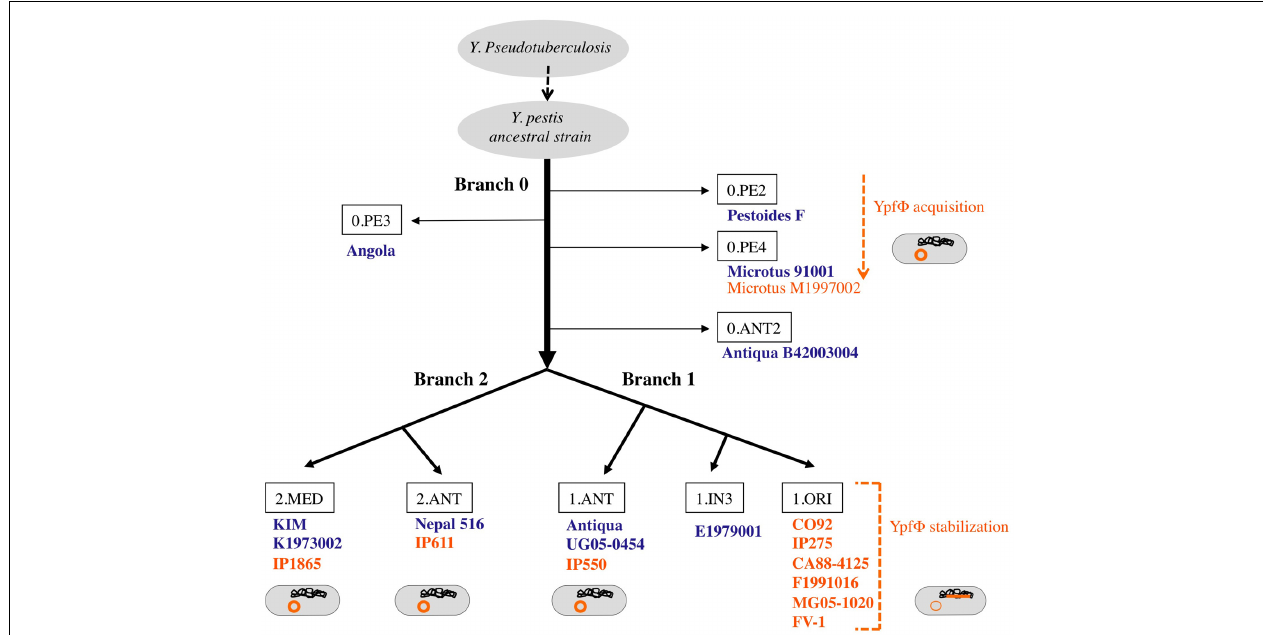
FIGURE 2 | Microevolution tree of Y. pestis . Strains in which noYpf (cid:2) was identified in the sequenced genome are indicated in blue. Strains from which a phage genome was detected by PCR and/or sequencing are indicated in orange.The location of the phage genome within the bacterial cell is schematized in